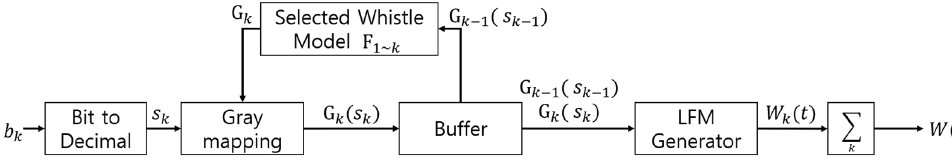
Figure 5. Block diagram of the proposed biomimicking modulation.